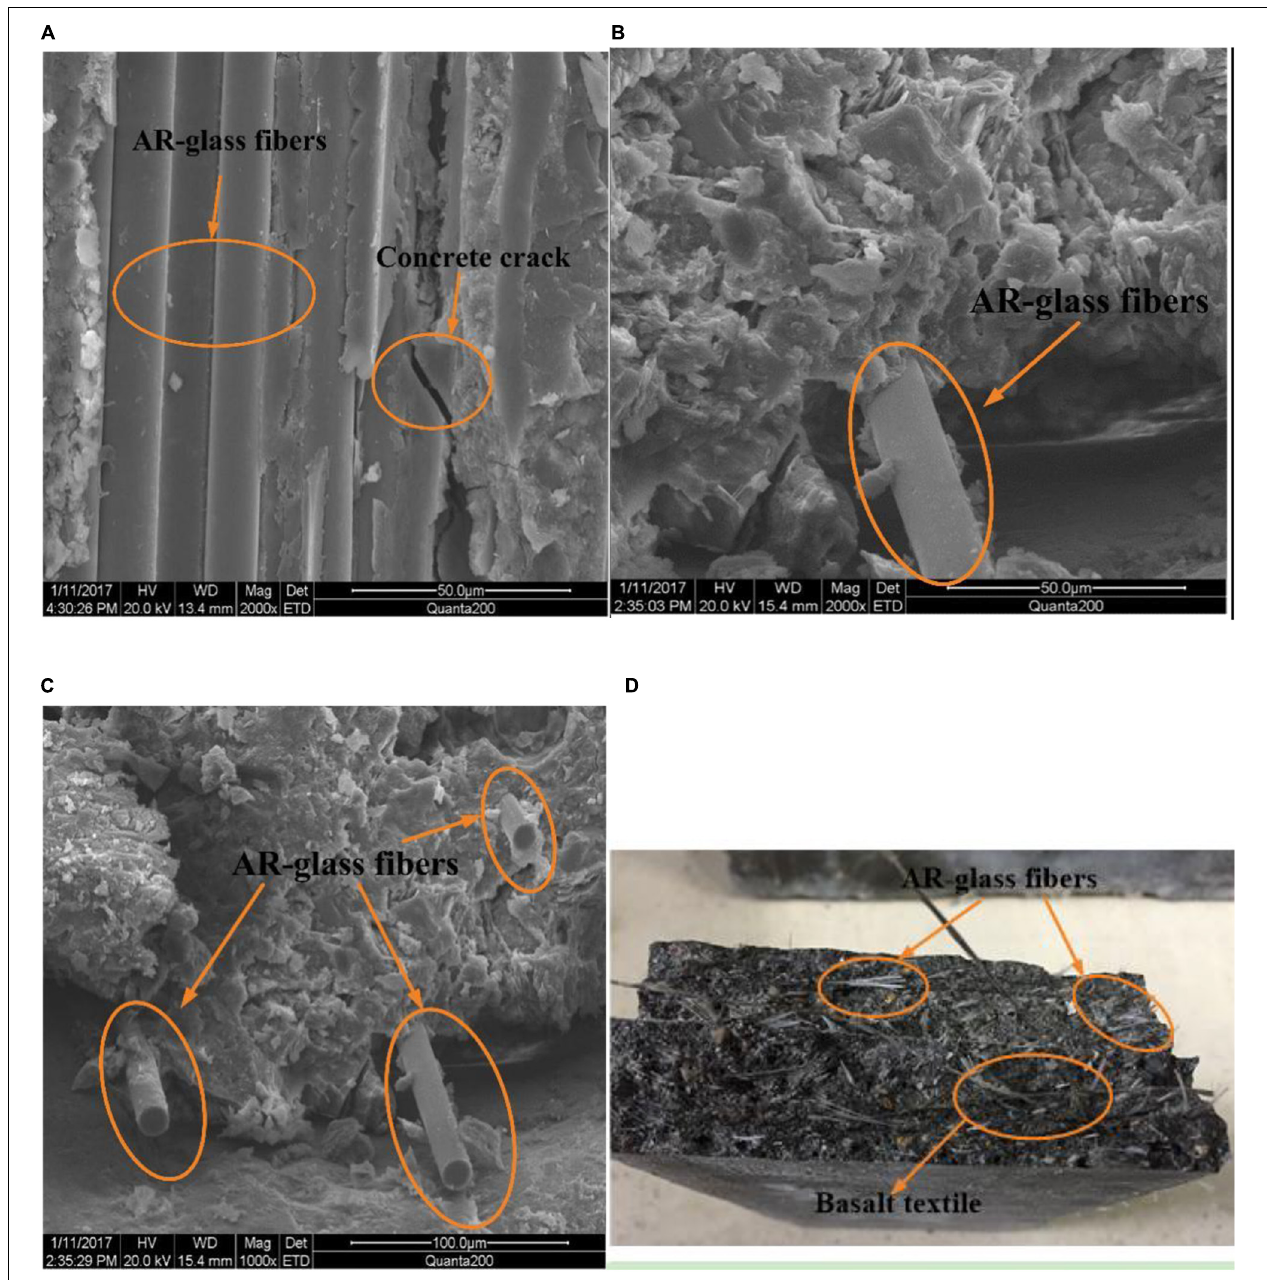
FIGURE 11 | Morphology observations of short fibers and textile in fine-grained concrete. (A) Cracking resistance of short fiber, (B) bridging role of short fiber, (C) uniformly distributed of short fibers, and (D) recombination of short fibers and